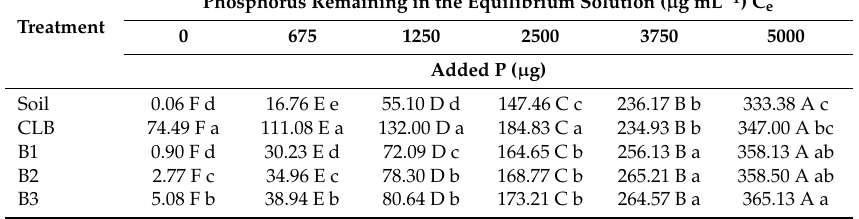
Table 5. Added Phosphorus concentration on equilibrium solution phosphorus concentration in di ff erent treatments.